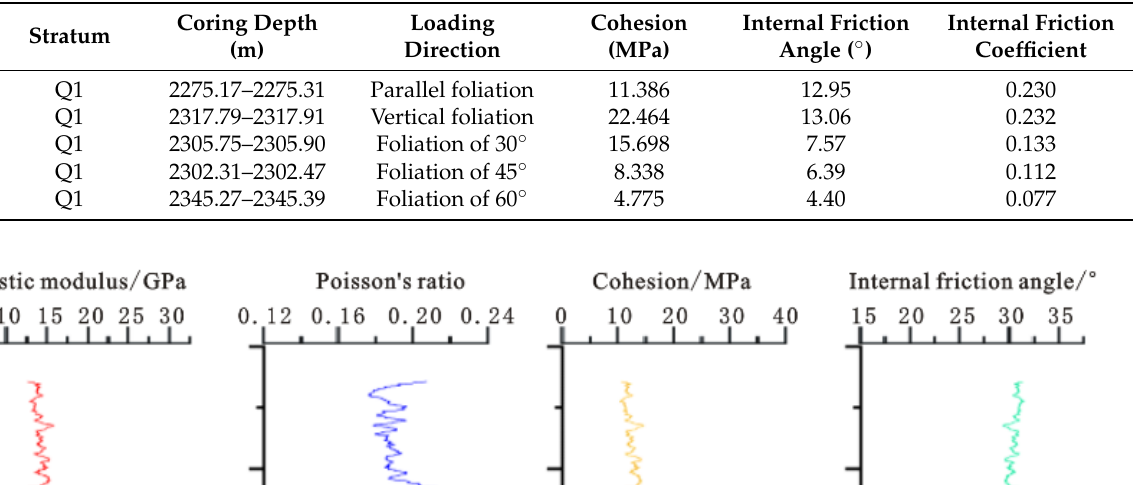
Table 2. Test of rock mechanical property parameters of dry shale samples in Block GL.